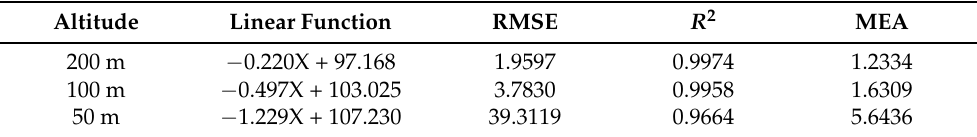
Table 2. The effect of a drone’s altitude on the performance; the results are presented for location #2 and various altitudes, with a drone speed of 5 m/s (18